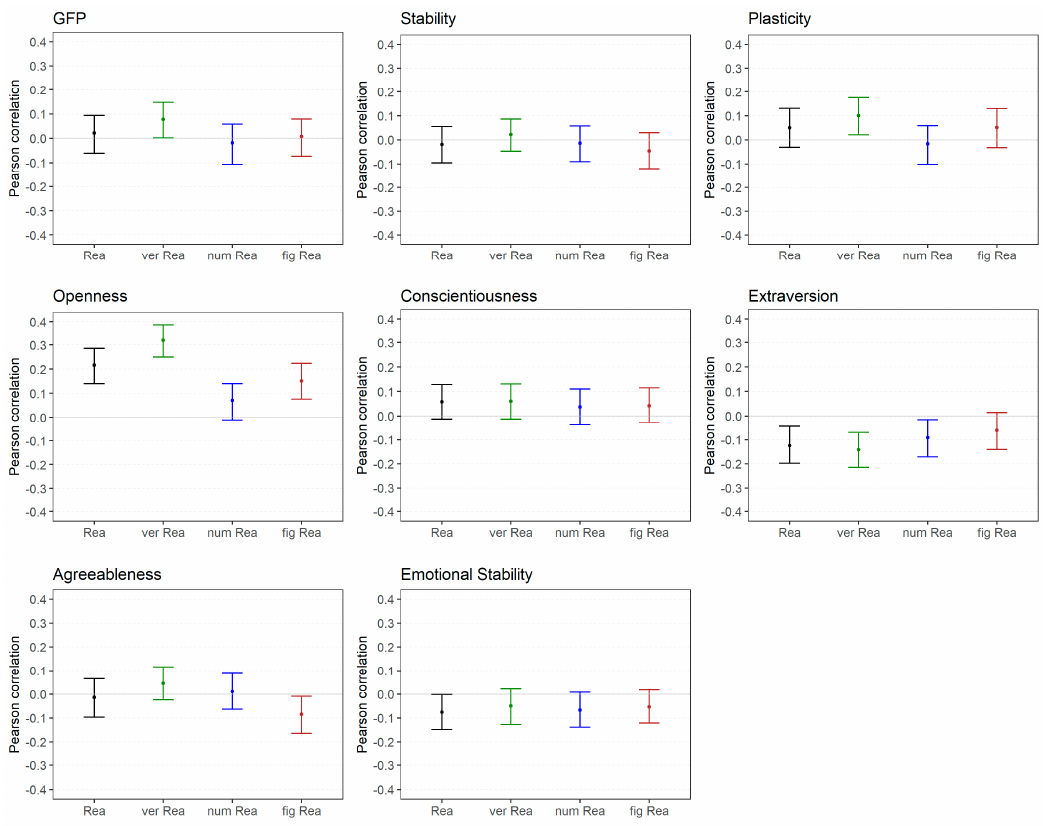
Figure 3. Study 1: Correlations between reasoning and higher-order factor scores as well as FFM dimensions scores of personality. Rea = reasoning, ver = verbal, num = numerical, fig = figural.